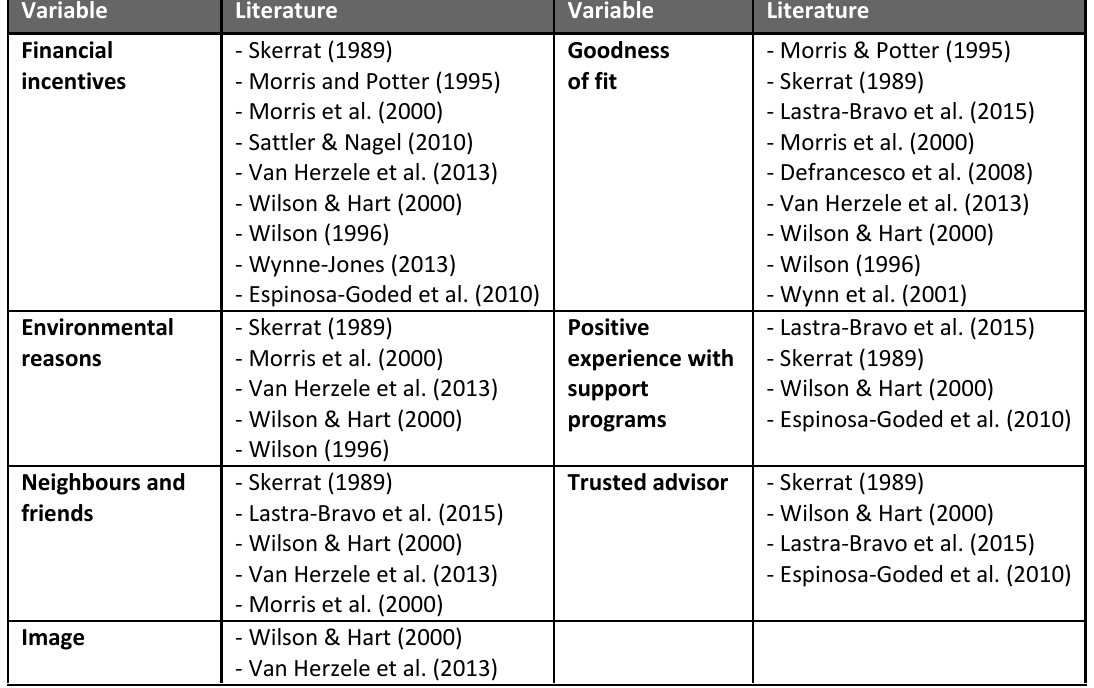
Table 1: Motivations to Participate